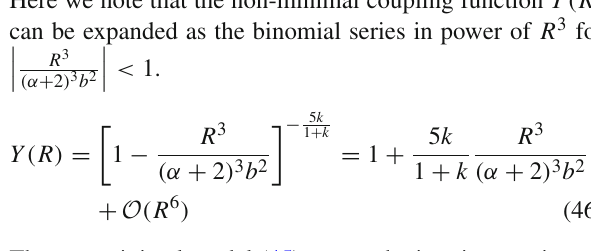
The solution of the inequality (42)